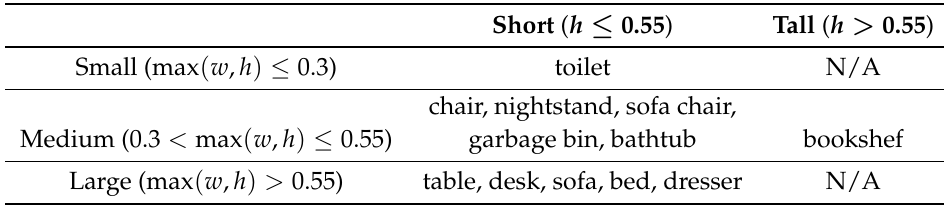
Table 1. Objects are classified into 4 categories based on there average physical size. Voxelization is processed based on each